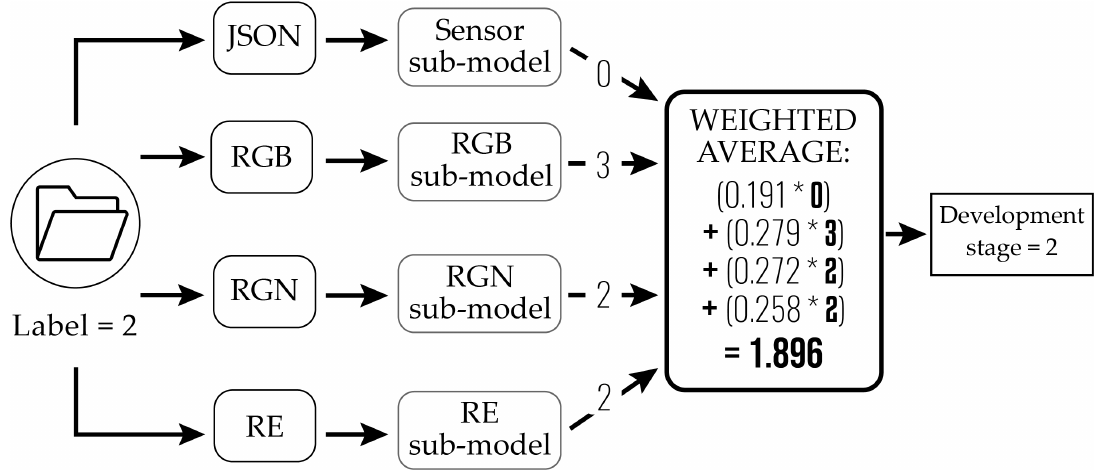
Figure 12. Machine learning classification